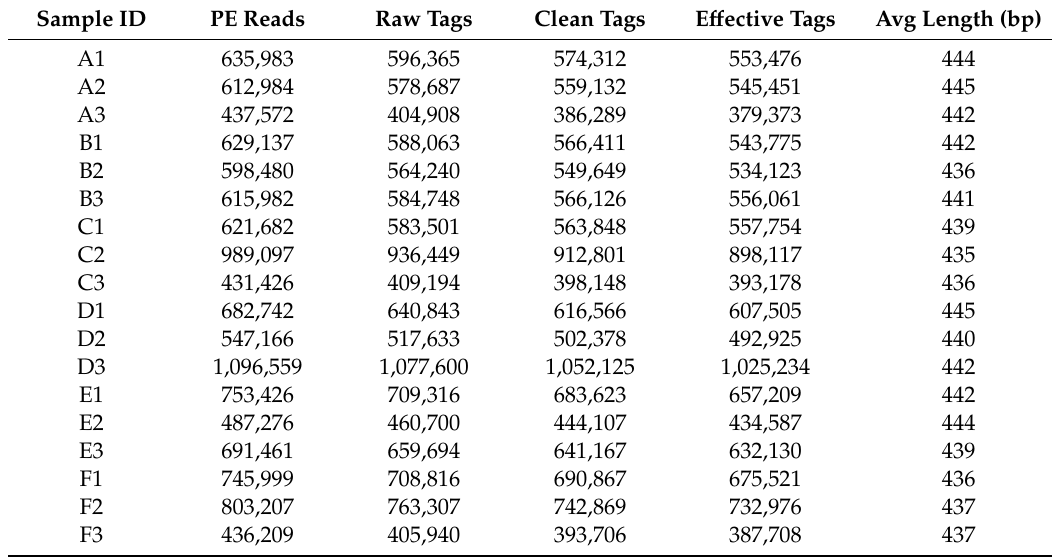
Table 2. Valid data statistics of the C. camphora samples.